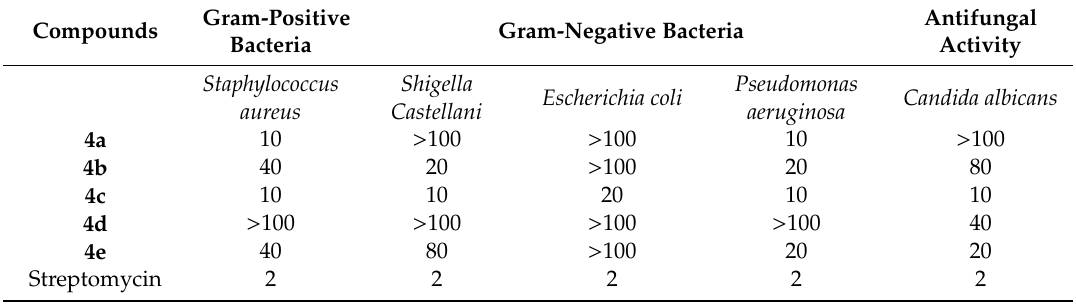
Table 2. Antibacterial activity of 4a–4e presented as the minimum inhibitory concentration (MIC) ( µ M).